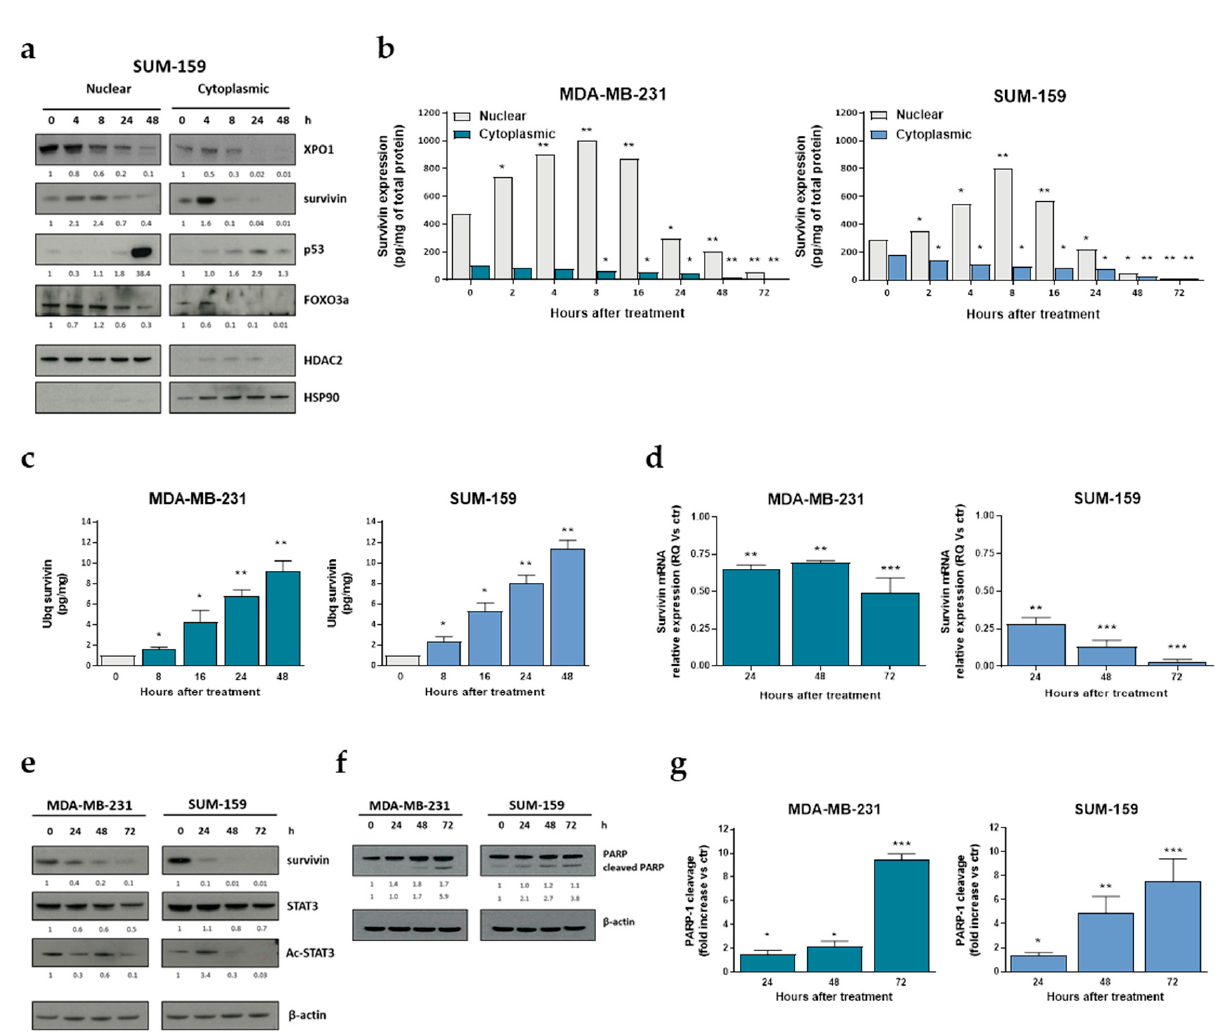
Figure 2. Effect of selinexor on survivin expression in TNBC cell lines. ( a ) Representative western blot showing nuclear and cytoplasmic fractions of XPO1 and survivin in TNBC cells exposed to selinexor (IC 50 at 72 h, as reported in Table 1). HDAC2 and HSP90 were used to confirm equal protein loading on the gel and to show the relative purity of the nuclear and cytosolic fractions, respectively. Cropped images of selected proteins are shown. For each protein, band density was quantified using ImageJ normalized to loading control and referred to respective untreated control.( b ) Quantification of nuclear and cytosolic survivin protein levels by ELISA assay in TNBC cells exposed to selinexor (IC 50 at 72 h). Data are reported as amount (pg) of survivin normalized to total (mg) protein extract, and represent the mean values ± SD of three independent experiments. ( c ) Quantification of ubiquitinated (Ubq)-nuclear survivin protein levels by ELISA assay in TNBC cells exposed to selinexor (IC 50 at 72 h). Data are reported as amount (pg) of Ubq-nuclear survivin normalized to total (mg) nuclear protein extract, and represent the mean values ± SD of three independent experiments. ( d ) Quantification of survivin mRNA expression levels by qRT-PCR in TNBC cells exposed to selinexor (IC 50 at 72 h) at different intervals. Data are reported as relative quantity (RQ) in selinexor-treated cells with respect to control cells exposed to 0.01% DMSO (ctr), and represent the mean values ± SD of three independent experiments. ( e ) Representative western blotting showing the expression of survivin, STAT3 and Ac-STAT3 in TNBC cells exposed to selinexor (IC 50 at 72 h) at different intervals. β -actin was used to confirm equal protein loading on the gel. Cropped images of selected proteins are shown. ( f ) Representative western blotting showing the cleavage of PARP-1 in selinexor-treated (IC 50 at 72 h) TNBC cell lines. Cropped images of selected proteins are shown. ( g ) Quantification of PARP-1 cleavage. Data are expressed as mean values ± SD of three independent experiments. * p < 0.05, ** p < 0.01, *** p < 0.005, Student ′ s t -test.